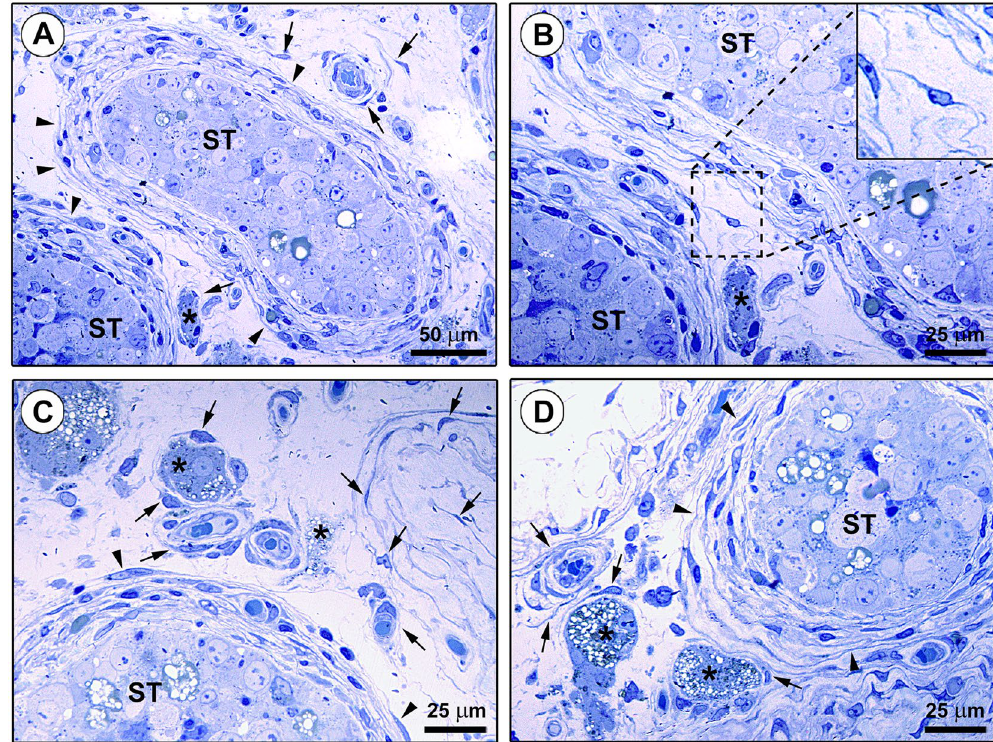
Figure 5. Light microscopy photomicrographs of toluidine blue-stained human testis semithin sections. ( A–D ) Numerous spindle-shaped interstitial cells with very long and thin moniliform cytoplasmic processes are observed in the connective tissue surrounding the seminiferous tubules (ST) (arrowheads). These cells are also broadly distributed in the intertubular stromal space (arrows), where they can be found either in neutral position or around microvessels and steroidogenic Leydig cells (asterisks). The boxed area in ( B ) is shown at higher magnification in the inset; note the bipolar morphology of a spindle-shaped interstitial cell with a cell body containing a large nucleus and very small amount of cytoplasm from which abruptly originate two long and thin moniliform prolongations which are rather convoluted. Scale bar: 50 µ m ( A ), 25 µ m ( B–D